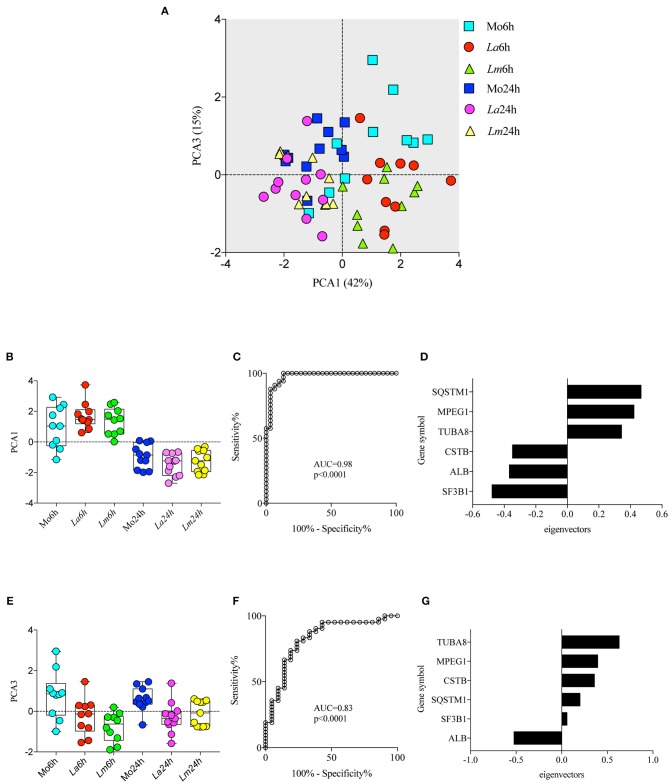
Principal Component Analysis (PCA) associated with experimental conditions. PCA was employed to reduce dimensionality and extract principal components using linear combinations of the six selected proteins in the dataset (A) Principal component 1 (PCA1) and principal component 3 (PCA3) scores are depicted in a two-dimensional scatterplot for each sample. Associations between cell culturing times and PCA1 scores (B,C) and Leishmania infection conditions and PCA3 scores (E,F) are represented by box plot and dot plot graphs (B,E) and ROC curve analysis (C,F). (D,G) Bar graph depicting protein eigenvectors values for PCA1 (D) and PCA3 (G). PCA1 scores are characterized by the positive eigenvector values of SQSTM1, MPEG1, and TUBA8, and the negative eigenvector values of CSTB, ALB, and SF3B1. PCA3 scores are characterized by the positive eigenvector values of TUBA8, MPEG1, and CSTB, and the negative eigenvector values of SQSTM1, SF3B1, and ALB.